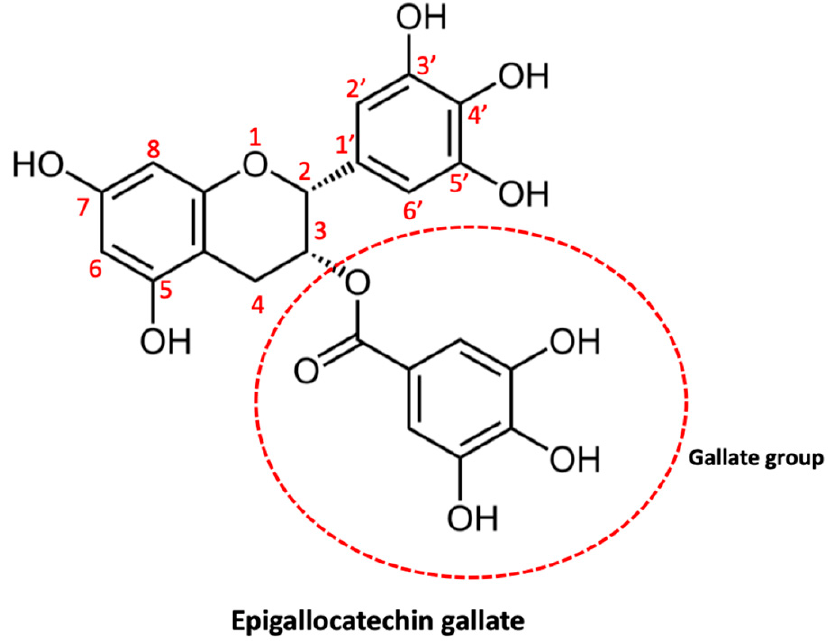
Figure 5. Molecular structure of epigallocatechin gallate.